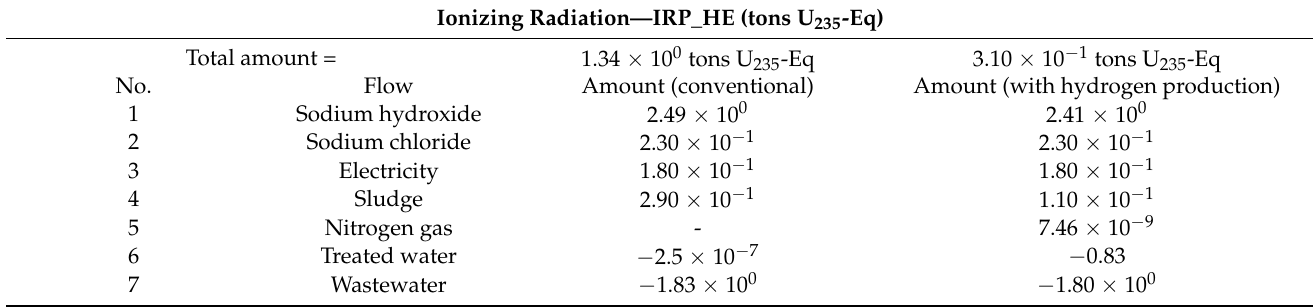
Table 9. Details of ionizing radiation impact before and after bio-hydrogen gas production.